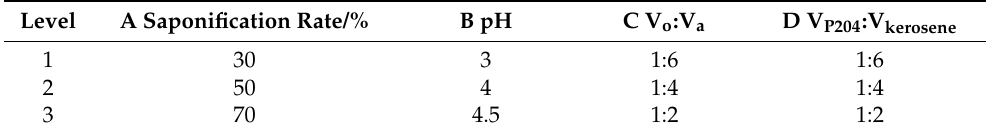
Table 2. Orthogonal experimental conditions for P204